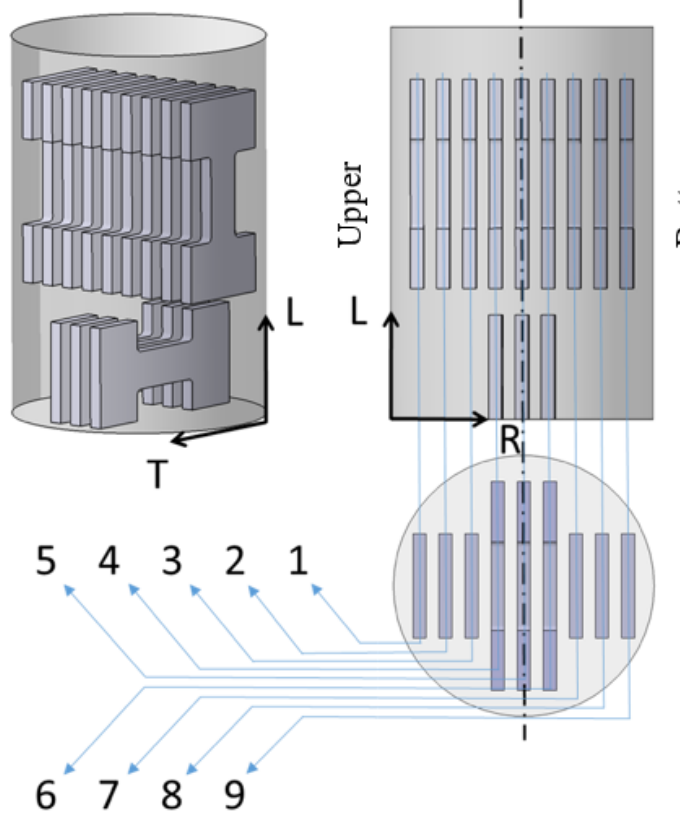
Figure 4. Cutting scheme of the processed wire.